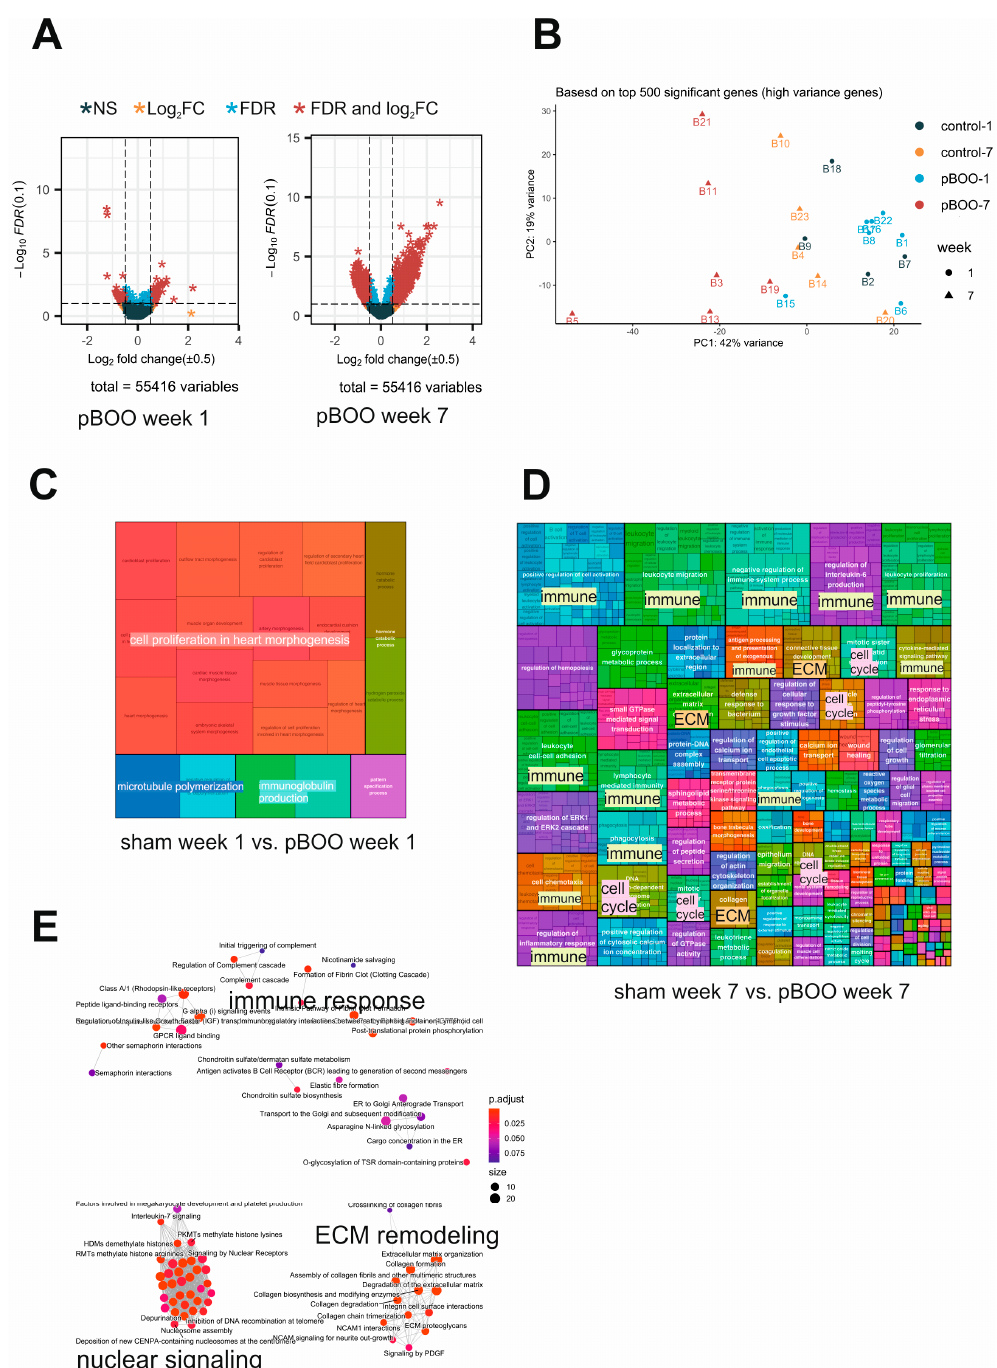
Figure 5. Transcriptome analysis of pBOO mouse bladders. ( A ) Volcano plot of all DEGs at week 1 and week 7 vs. respective shams. mRNAs with p -value < 0.05, absolute log2 fold change > 0.5 (in red) were selected for further analysis. ( B ) Principal component analysis of the RNA sequencing data in a 2D graph of PC1 and PC2 based on normalized read counts of all mRNA with adjusted p -value < 0.05, absolute log2 fold change > 0.5 and mean of read counts > 50 reads. The bi-plot shows samples as labeled dots. ( C ) A treemap view of GO-term clusters (Biological Processes) at 1 week and 7 weeks ( D ) pBOO, and Reactome pathway analysis ( E ) at 7 weeks pBOO.